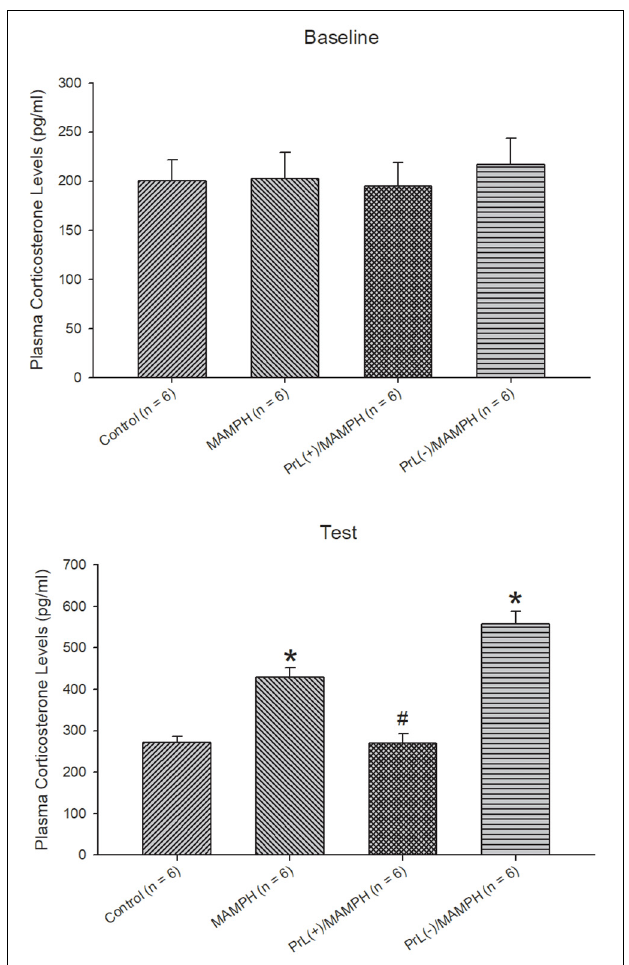
FIGURE 3 | The effect of MAMPH administrations on plasma corticosterone levels were tested using NMDA or saline injections into the PrL. Mean ( ± SEM) plasma corticosterone levels (pg/ml) were taken for the control ( n = 6), MAMPH ( n = 6), PrL(+)/MAMPH ( n = 6), and PrL(–)/MAMPH groups ( n = 6) at the baseline and in the conditioning phase. PrL(+): Injection of a low concentration of NMDA to excite the PrL neurons; PrL(–): Injection of a high concentration of NMDA to destroy the PrL neurons. Plasma corticosterone levels were analyzed by one-way ANOVA, followed by Tukey’s post hoc test if a significant difference was appeared among groups at the baseline and test phases. ∗ p < 0.05 indicates significant differences compared with the control group; # p < 0.05 indicates significant differences compared with the MAMPH